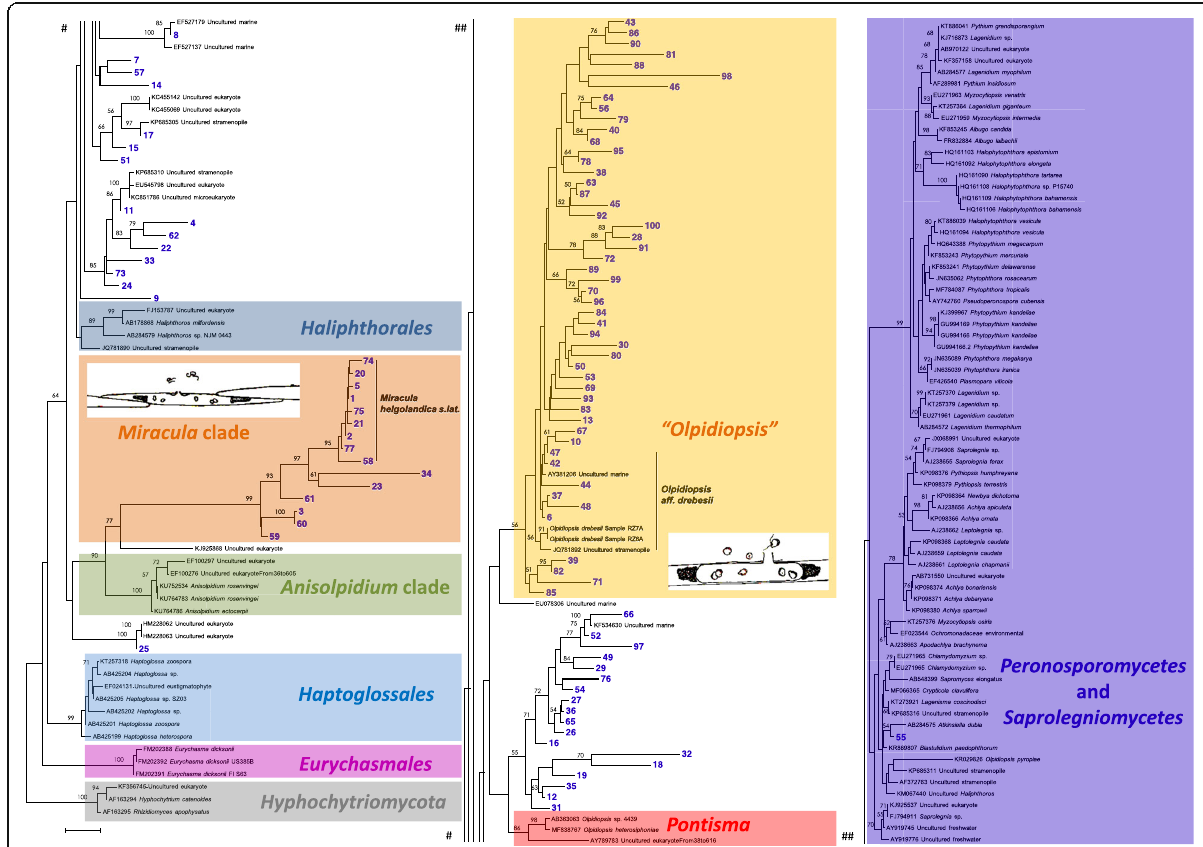
Fig. 4 Phylogenetic tree (Minimum Evolution) based on the V3 – 4 regions of the nrSSU of oomycetes. Bootstrap support values > 50% are given on the branches leading to the respective nodes. The bar indicates the number of substutions per